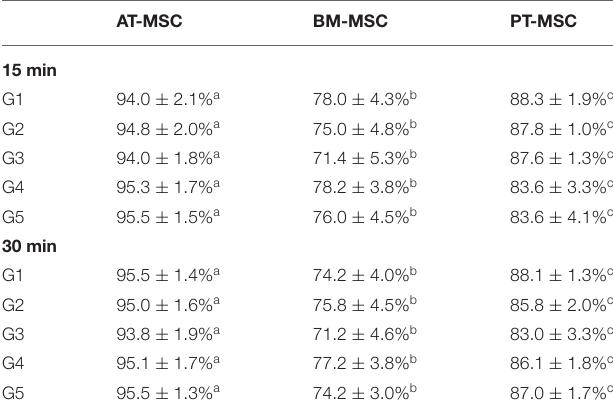
TABLE 4 | Mean percentages of viability of AT-MSC, BM-MSC, and PT-MSC after 15 and 30min of exposure to cryoprotectant solutions (mean ± SEM) (a–c) different letters indicate significant differences ( P < 0.001) between the tissues